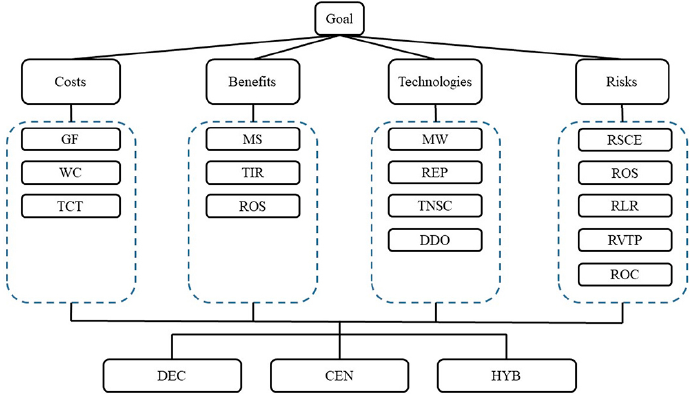
Figure 1. The research framework to evaluate the optimal token exchanges platform and critical factors in Taiwan